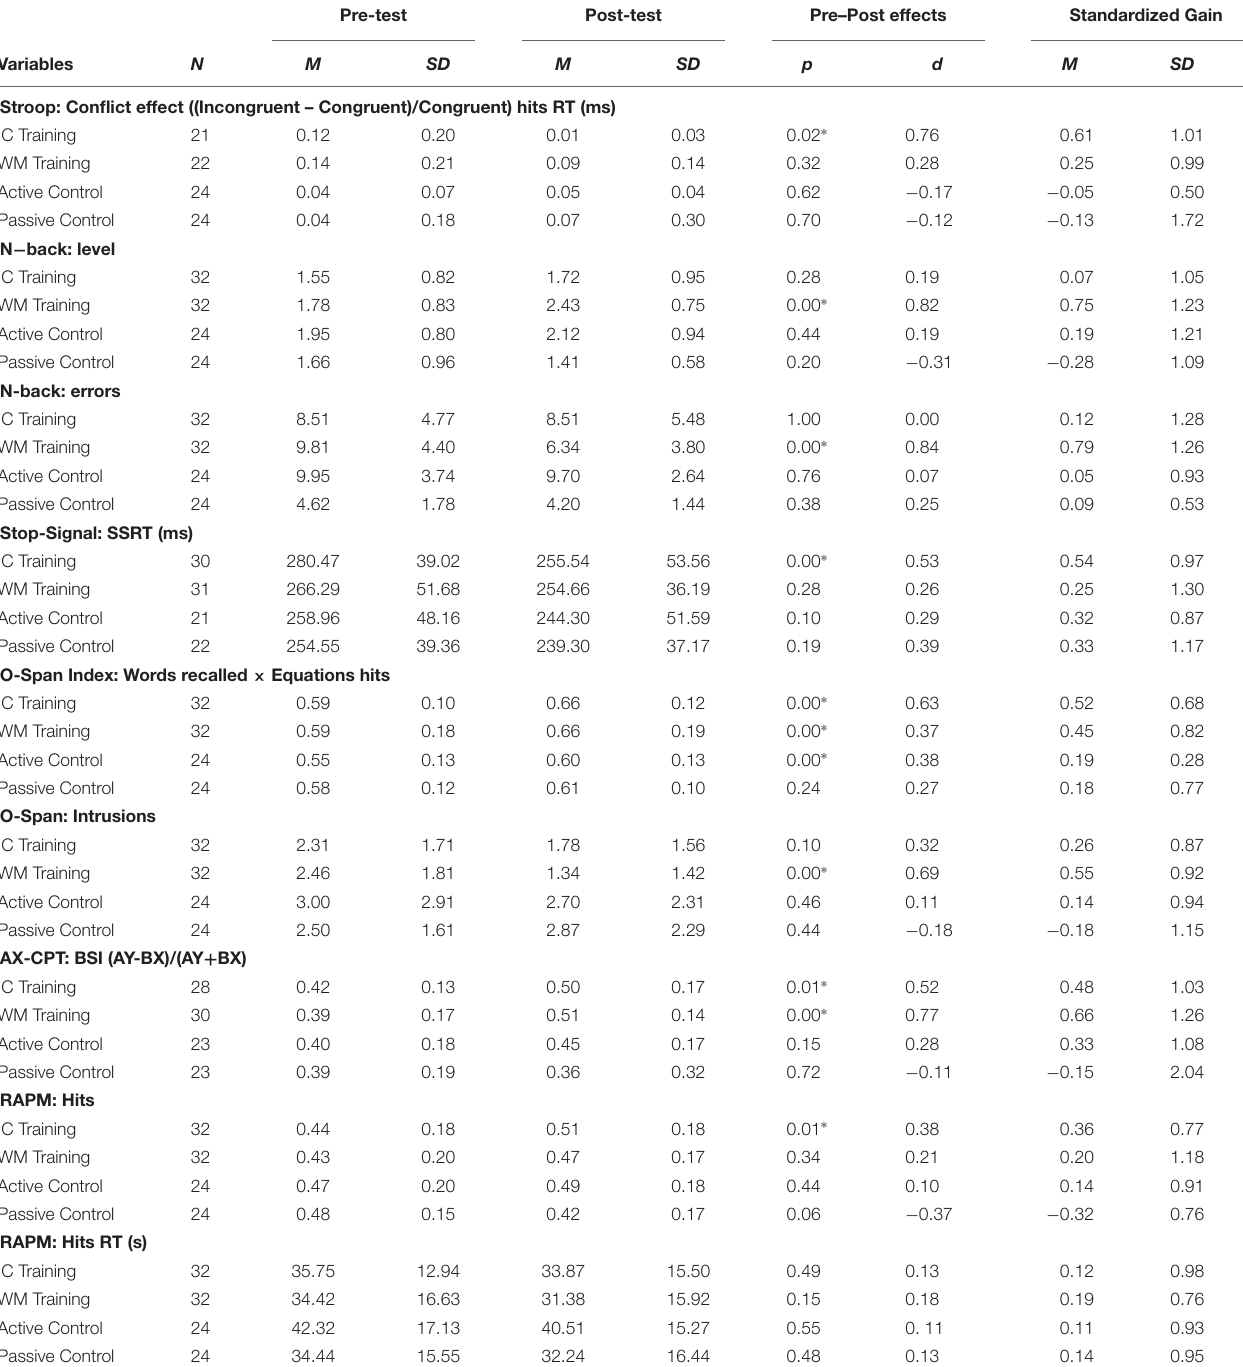
TABLE 1 | Descriptive statistics for outcome measures: Mean and standard deviations for the outcome measures in the pre- and post-testing. Pre-test Post-test Pre–Post